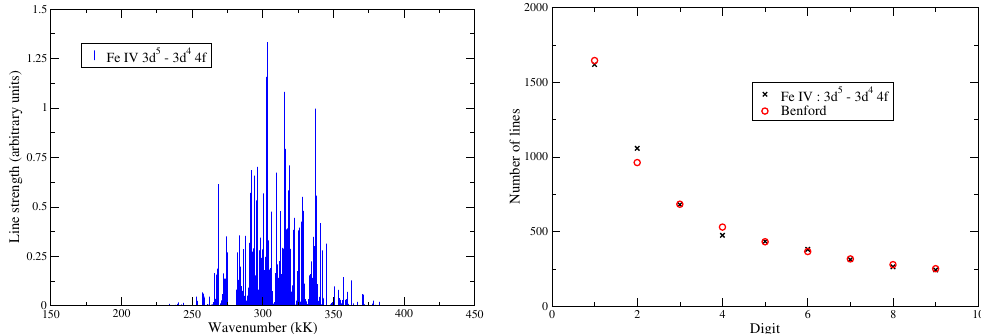
3 d 4 4 f (line strength as a function of energy) computed with Cowan’s Figure 11. Transition array 3 d 5 − code [56] and number of lines as a function of the first significant digit in the value of the strength.